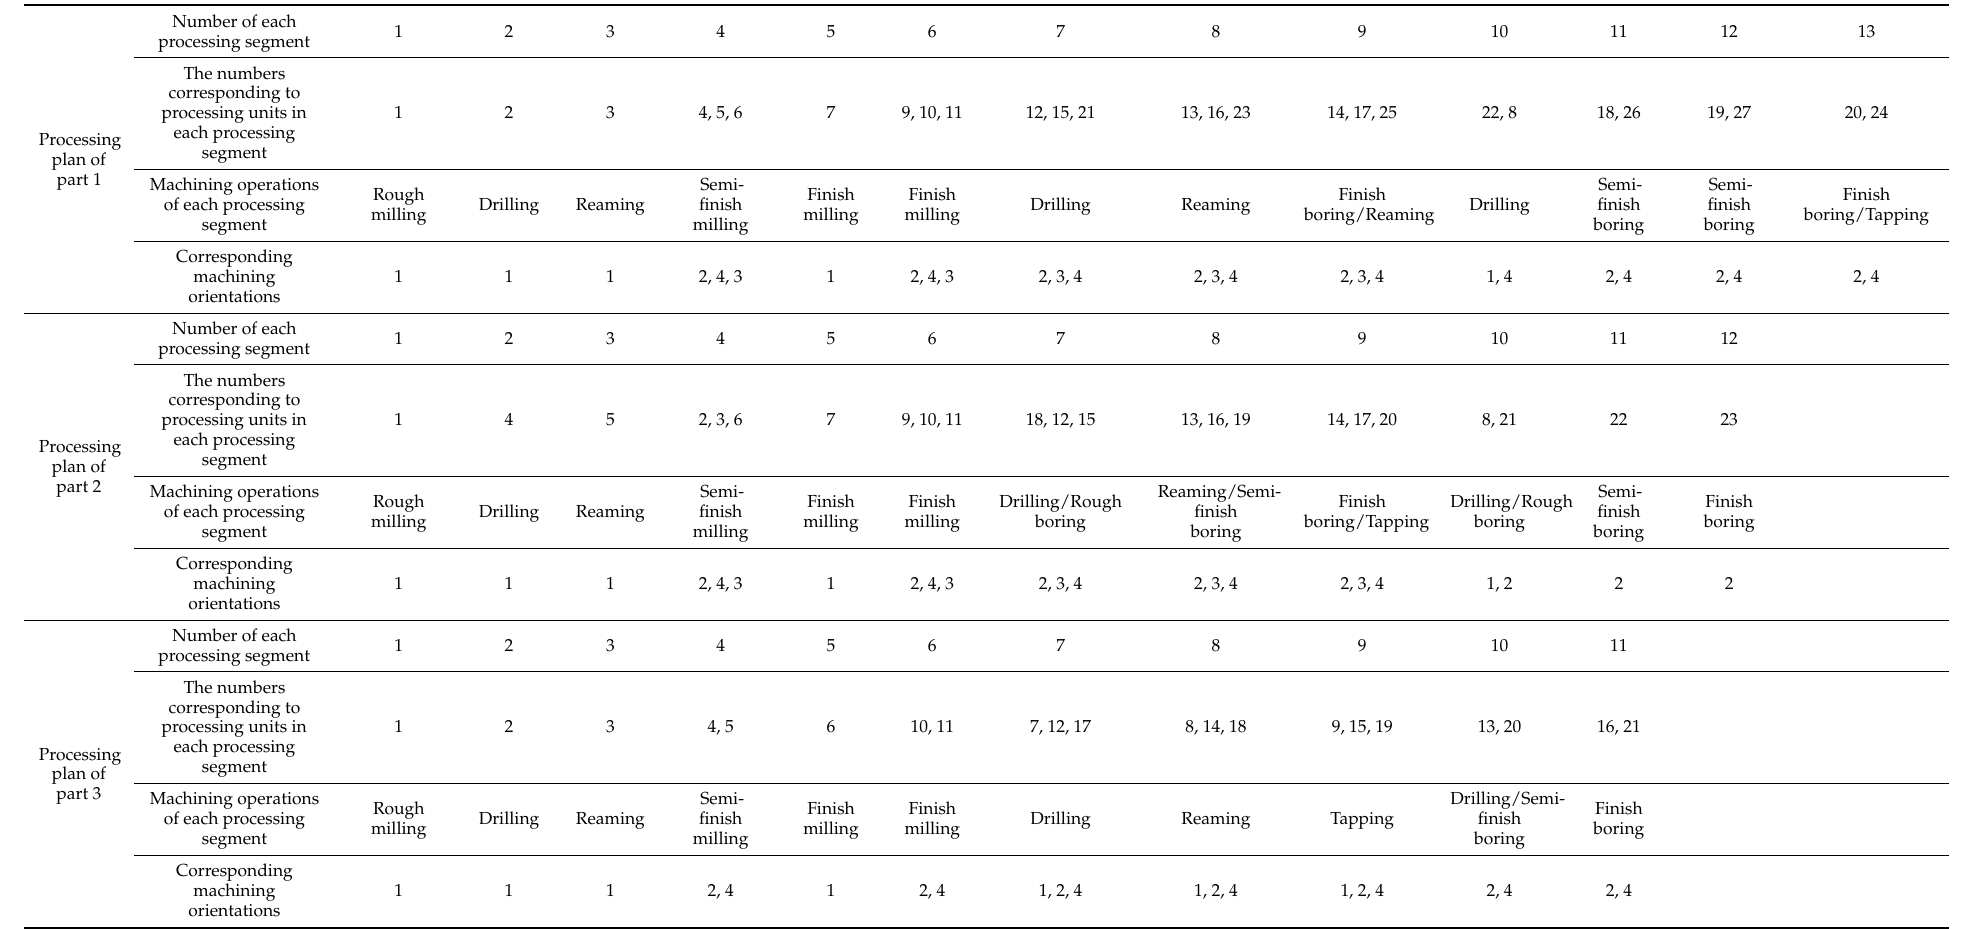
Table 4. Comparison of the processing information of the three parts’ processing